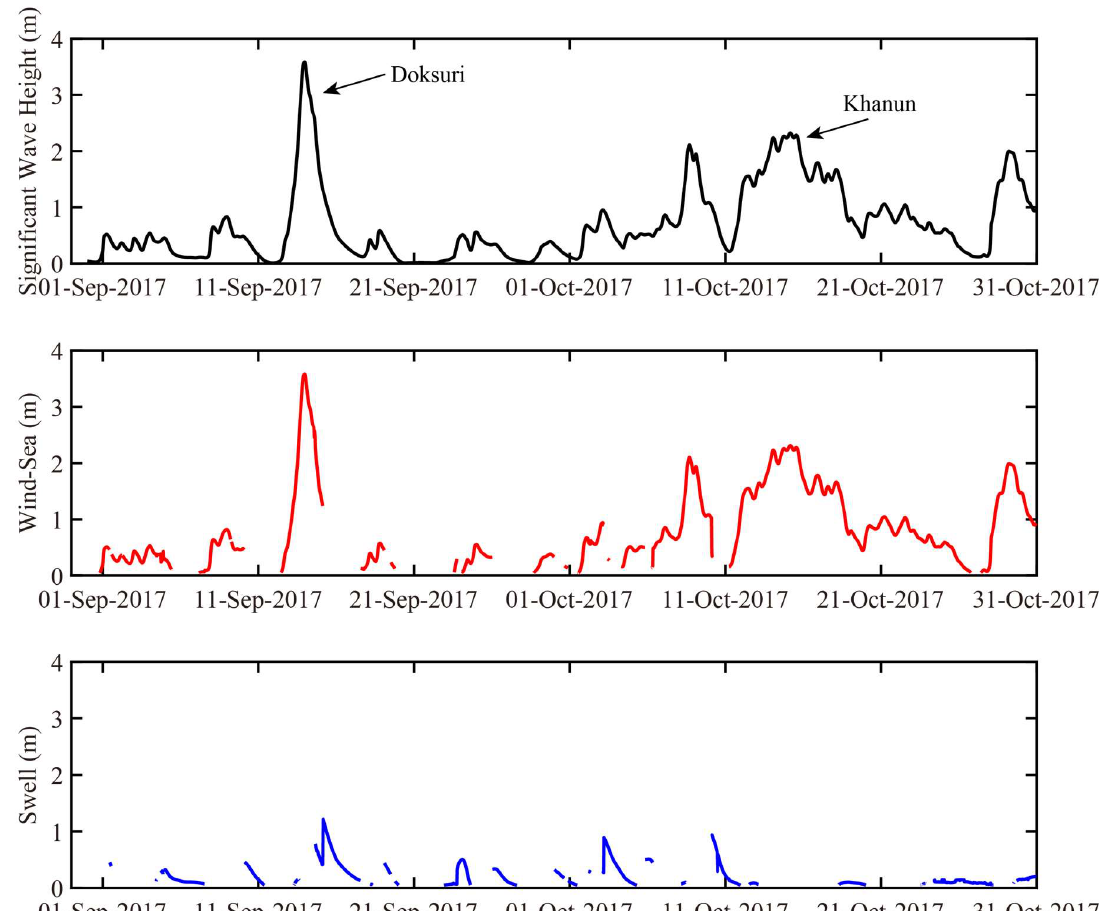
Figure 12. The time series at the point (19.5° N, 107.5° E) from 1 September 2017 to 31 October 2017. ( a ) SWH; ( b ) wind-sea; and ( c ) swell.